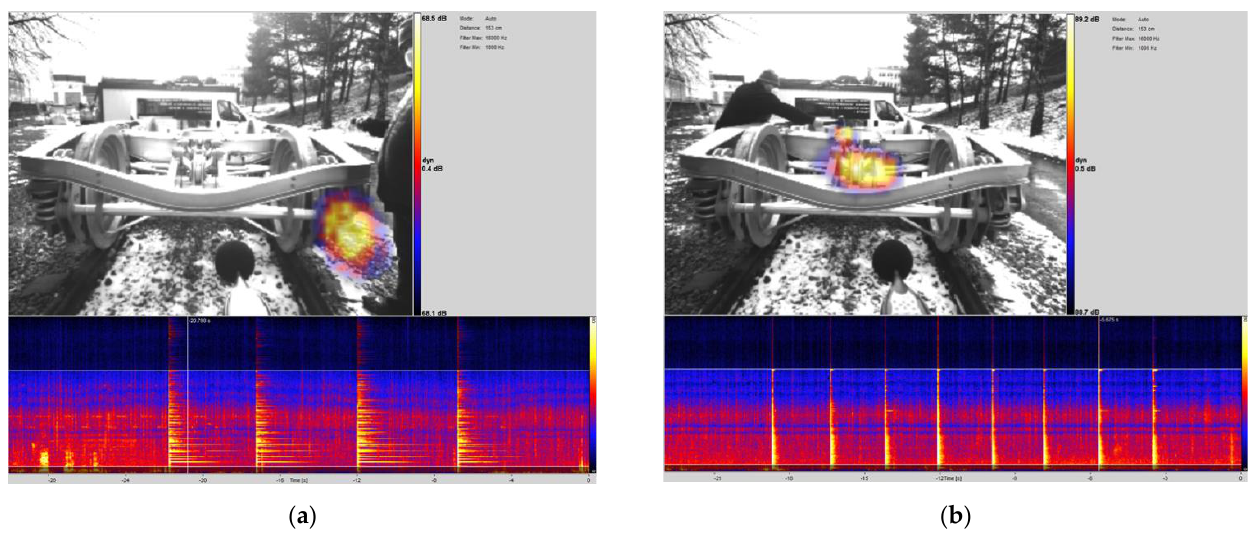
Figure 3. Recording from the acoustic camera — visualization of acoustic field radiated by excita- tion by impact hammer ( a ) wheel, and ( b ) main cross member. (Legend of spectrogram: horizontal axis — time; vertical axis — frequency range 1000 – 1400 Hz; and color scale — sound pressure level in dB).